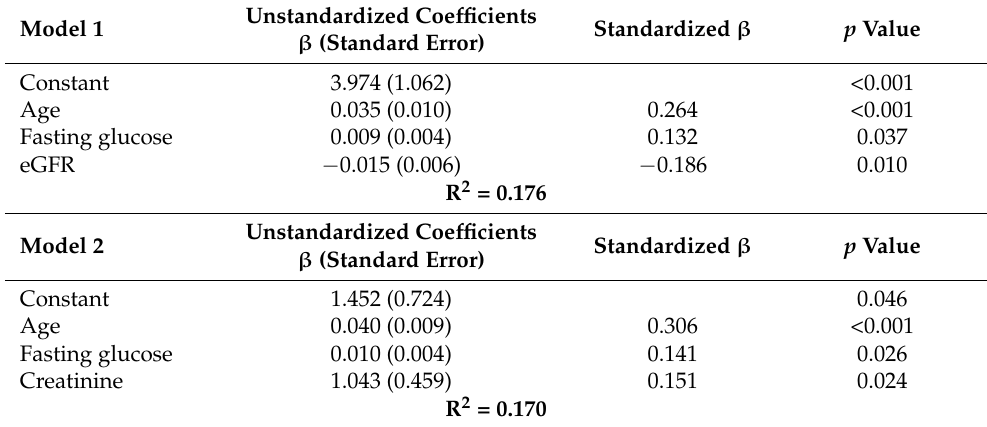
Table 2. Multivariate linear regression analyses of determinants associated with the salivary conductivity.